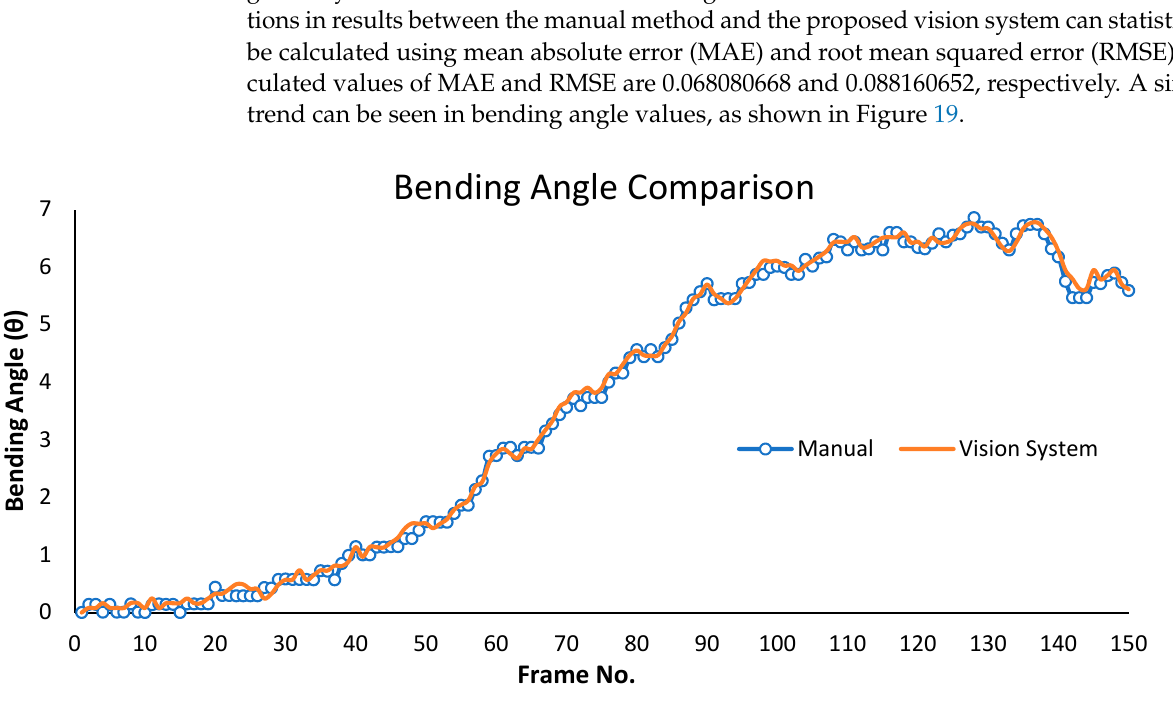
Figure 19. IPMC bending angle values obtained from manual calculation and vision system. The calculated values of MAE and RMSE for bending angle are 0.081544205 and 0.103880163, respectively. Low values of MAE and RMSE signify agreeable results